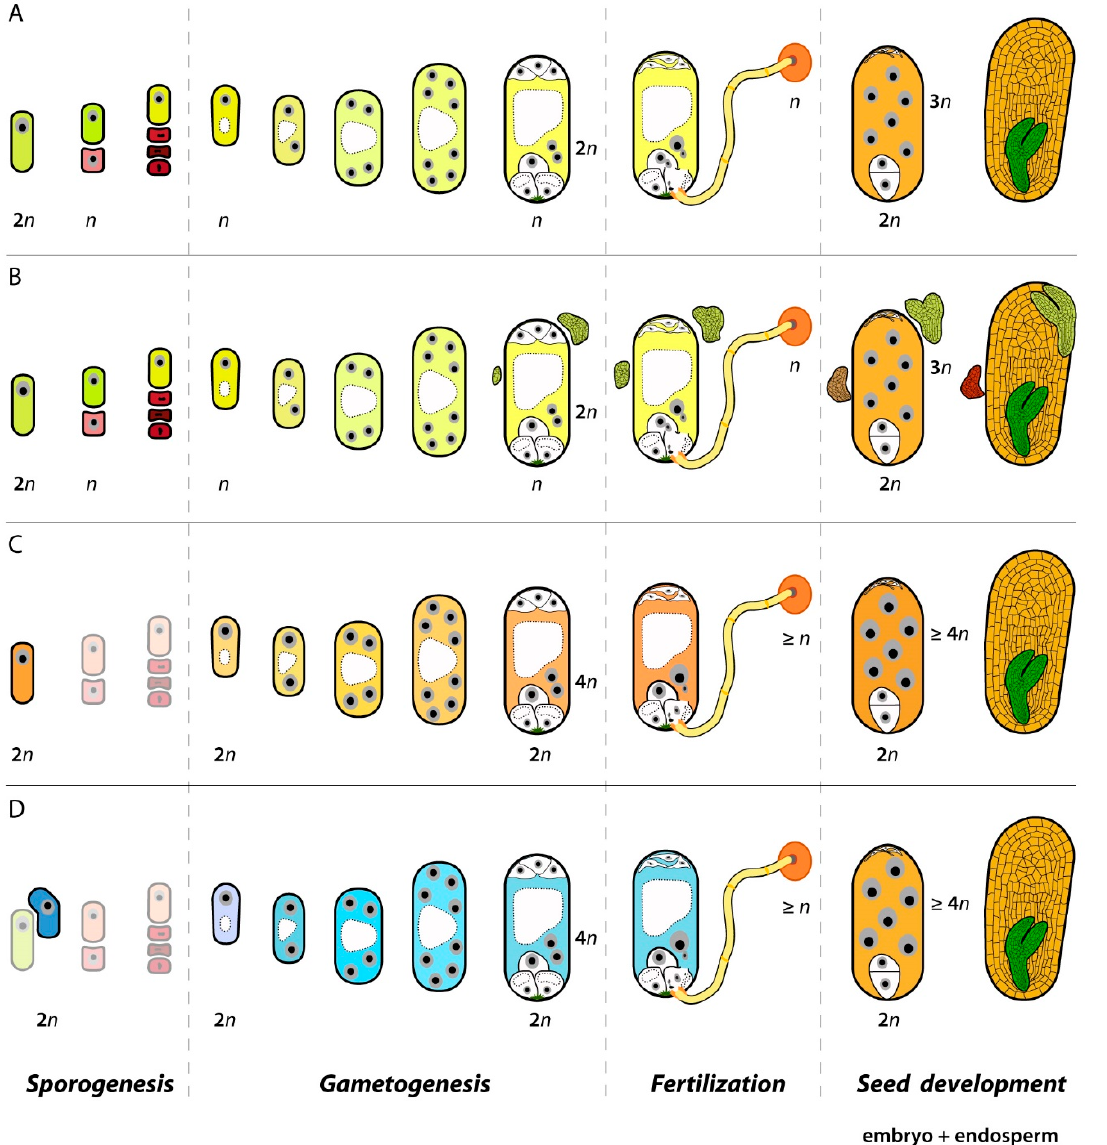
Figure 1. Pathways of seed formation in plants. At least one or two reproductive modules or developmental programs are distinctively altered between sexual ( A ) and apomictic developments ( B – D ). In sporophytic apomixis, a clonal embryo developed from the surrounding somatic tissue replace the zygotic embryo ( B ). In gametophytic apomixis, sporogenesis, or the acquisition of a megaspore mother cell identity and progression through meiosis is the first altered developmental program. In diplospory ( C ) meiosis is bypassed, while in apospory ( D ) it is highly depleted and surrounding somatic cells acquire a megaspore-like fate. Gametogenesis, or the formation of the female gametophyte, is generally conserved in the three pathways. The second developmental step that is altered is fertilization, i.e., the delivery of male gametes and fusion with the female ones. While in sexual plants double fertilization happens ( A ), in most apomicts only one fertilization event is possible due to parthenogenesis and this fertilization is required for developing the endosperm ( C and D ).